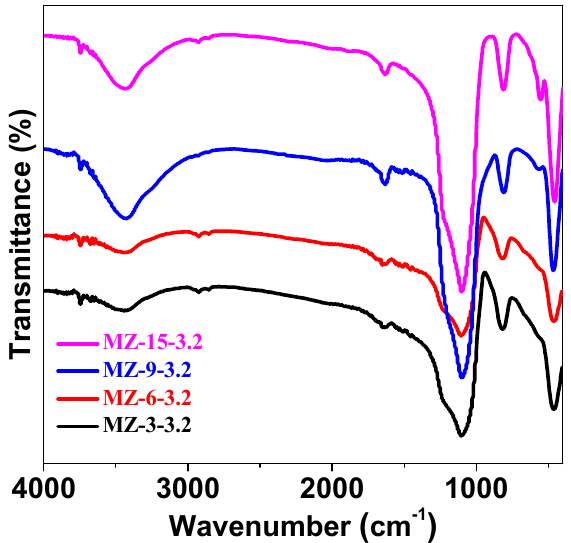
Catalysts 2018 , 8 , x FOR PEER REVIEW Figure 2. FT ‐ IR spectra of MZ ‐ 3 ‐ 3.2, MZ ‐ 6 ‐ 3.2, MZ ‐ 9 ‐ 3.2, and MZ ‐ 15 ‐ 3.2. Figure 2. FT-IR spectra of MZ-3-3.2, MZ-6-3.2, MZ-9-3.2, and MZ-15-3.2.